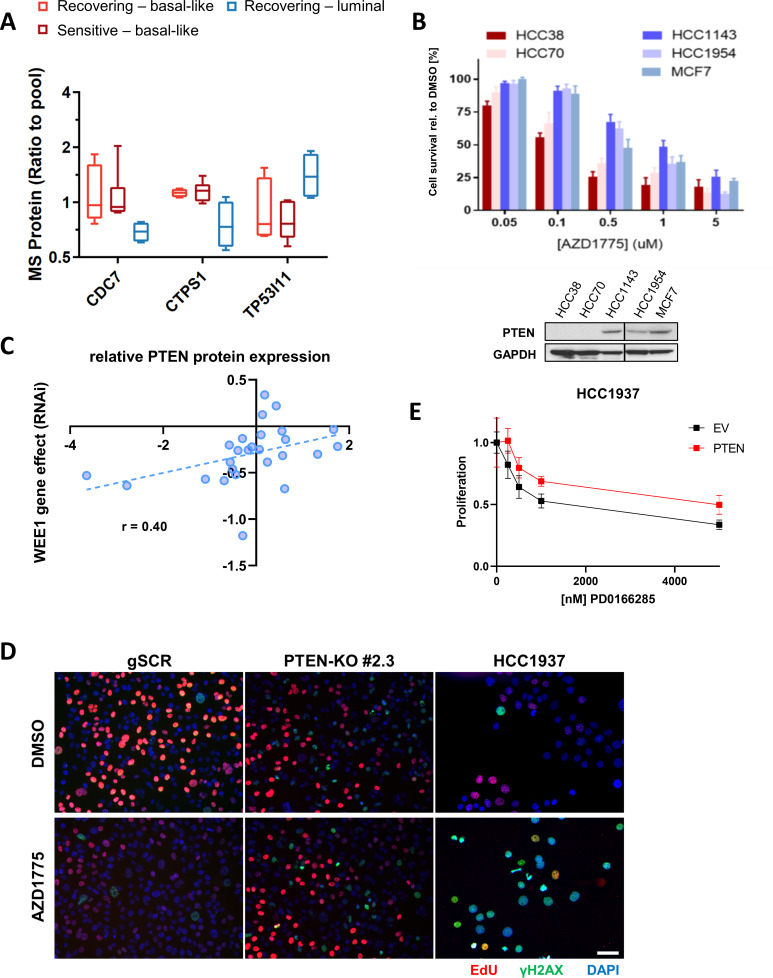
PTEN predicts sensitivity and response to AZD1775 monotherapy.(A) Box-plots of CDC7, TP53I11 and CTPS1 protein expression levels (ratio to pool) in the different groups of breast cancer cell lines according to AZD1775 response characteristics (recovering-basal, sensitive-basal and recovering-luminal). (B) AZD1775 drug response in HCC38, HCC70, HCC1143, HCC1954 and MCF7 cells as assessed by crystal violet staining and colorimetry after 72 hr treatment with increasing concentrations of AZD1775. Bottom panel shows PTEN expression by immunoblot analysis for a selection of the cell lines. GAPDH expression was used as loading control. (C) Correlation analysis of WEE1 RNAi gene dependency (combined RNAi, DEMETER2 model, depmap portal [McFarland et al., 2018; Tsherniak et al., 2017]) and PTEN protein levels (relative protein expression) in 26 breast cancer cell lines (Nusinow et al., 2020). Pearson’s correlation, r = 0.40, p=0.04; Spearman’s correlation, r = 0.50, p=0.01. (D) Representative images related to Figure 2E. PTEN-proficient (MDA-MB-231 scrambled control), PTEN-deficient (PTEN-KO #2.3) and PTEN-deleted HCC1937 cells were treated with AZD1775 (500 nM) or DMSO for 24 hr. EdU = red, γH2AX = green, DAPI = blue. Scale bar = 60 μm. (E) Quantification of response to WEE1 inhibitor PD0166285 in HCC1937 (EV, PTEN-negative) cells and HCC1937 cells with reconstituted PTEN expression. Cell viability was analysed by alamarBlue assay. Error bars indicate SD calculated from five replicates. **p<0.002 assessed by Student’s t-test.